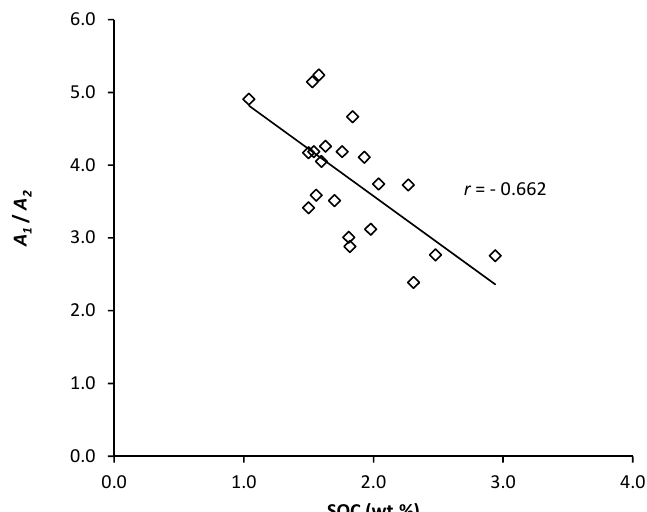
Figure 4. Soil organic carbon (SOC) content influence on the textural and structural porosity ratio ( A 1 / A 2 ).